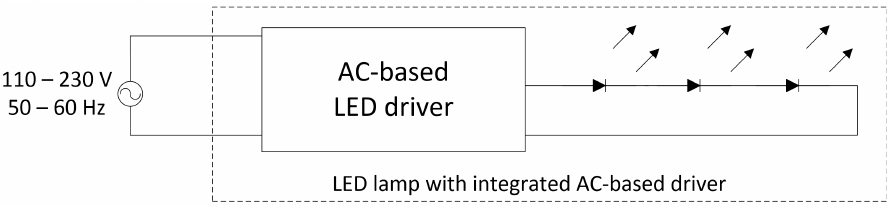
Figure 3. Schematic representation of LED lamp with integrated driver operating on